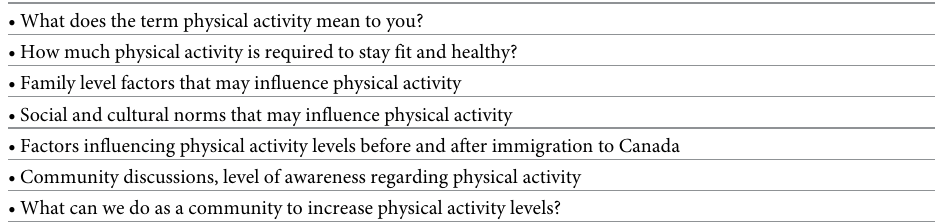
Table 1. Key questions used to lead focus group